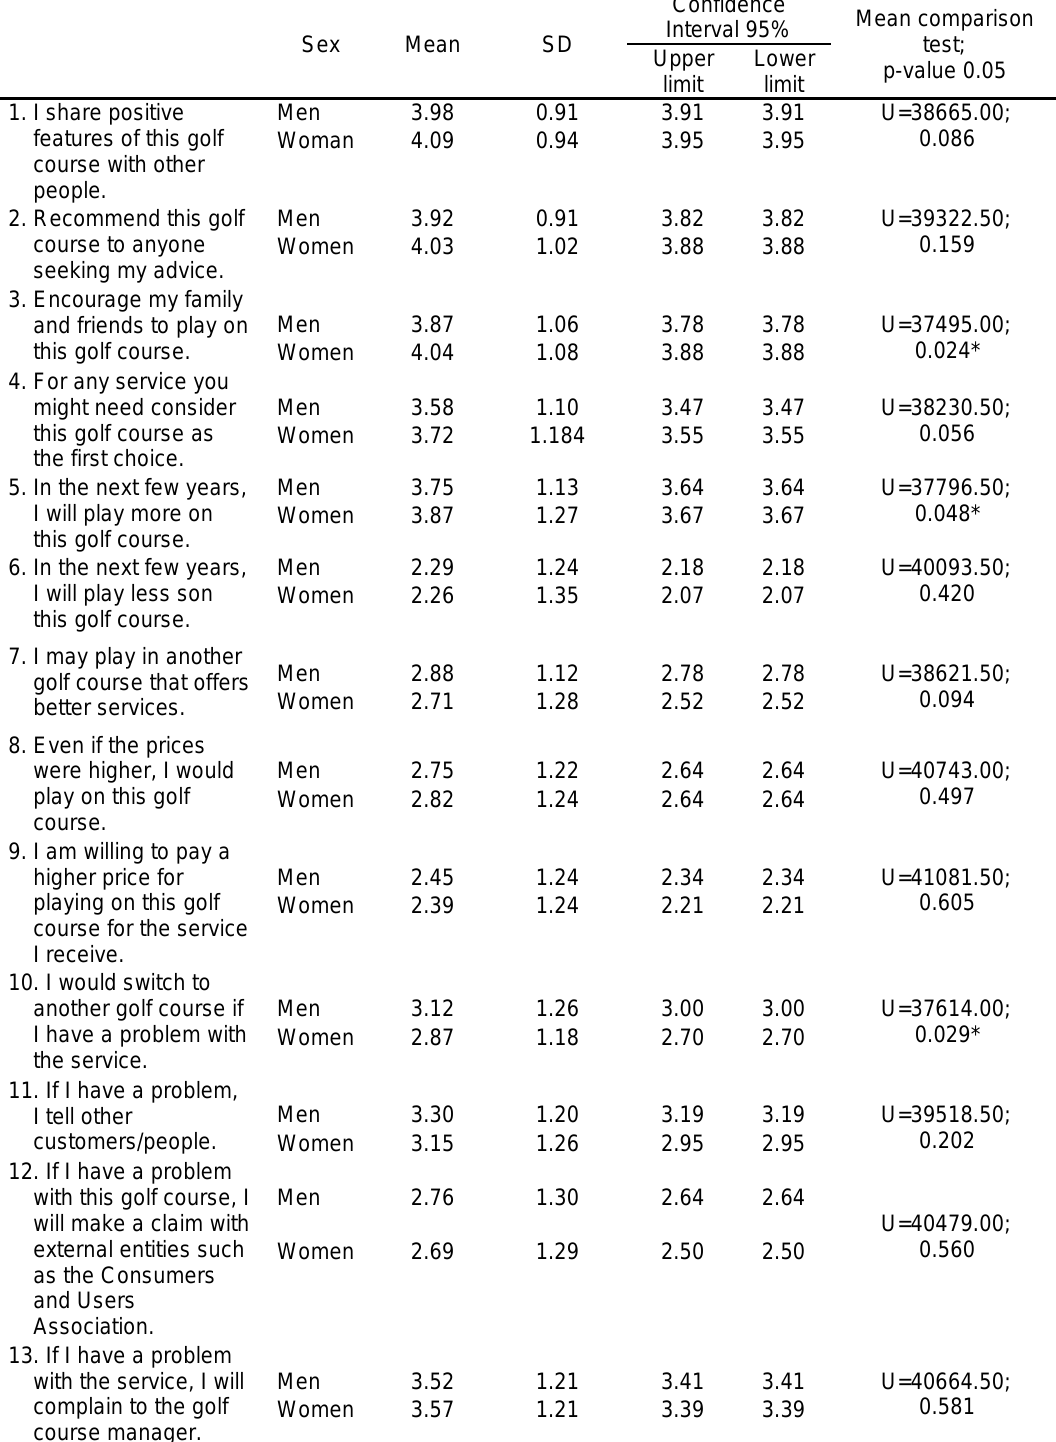
Table 4. Bivariate analysis of the dimension of Loyalty (V1-5), Price sensation (V6-9) y Response (V10-13) by